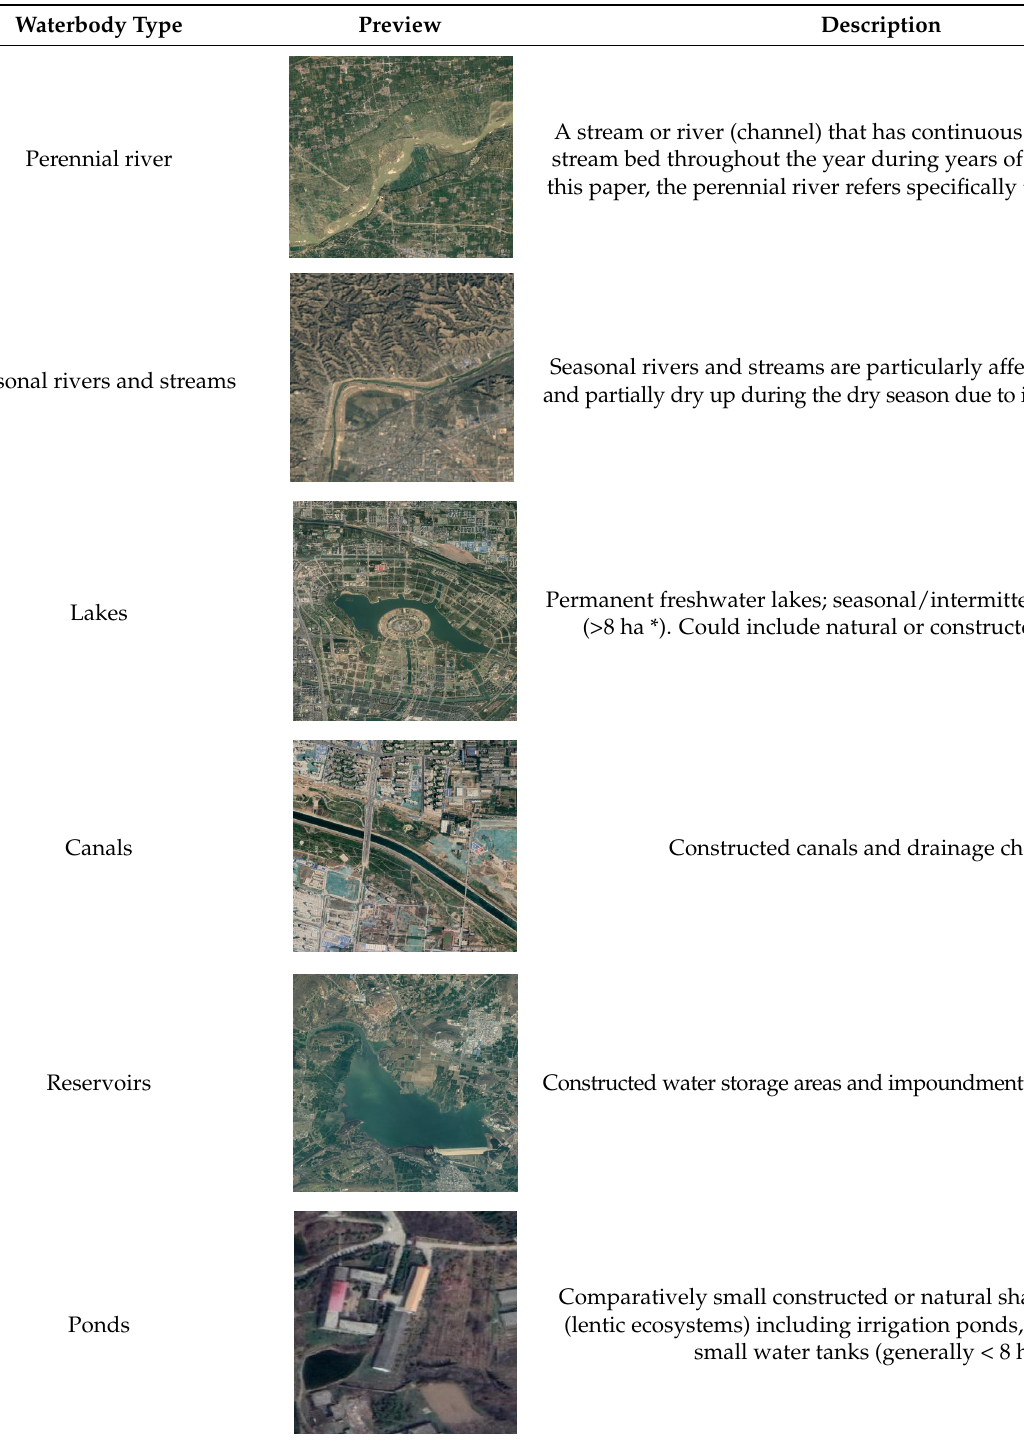
Table 1. Six classes of open waterbodies analyzed in this study.